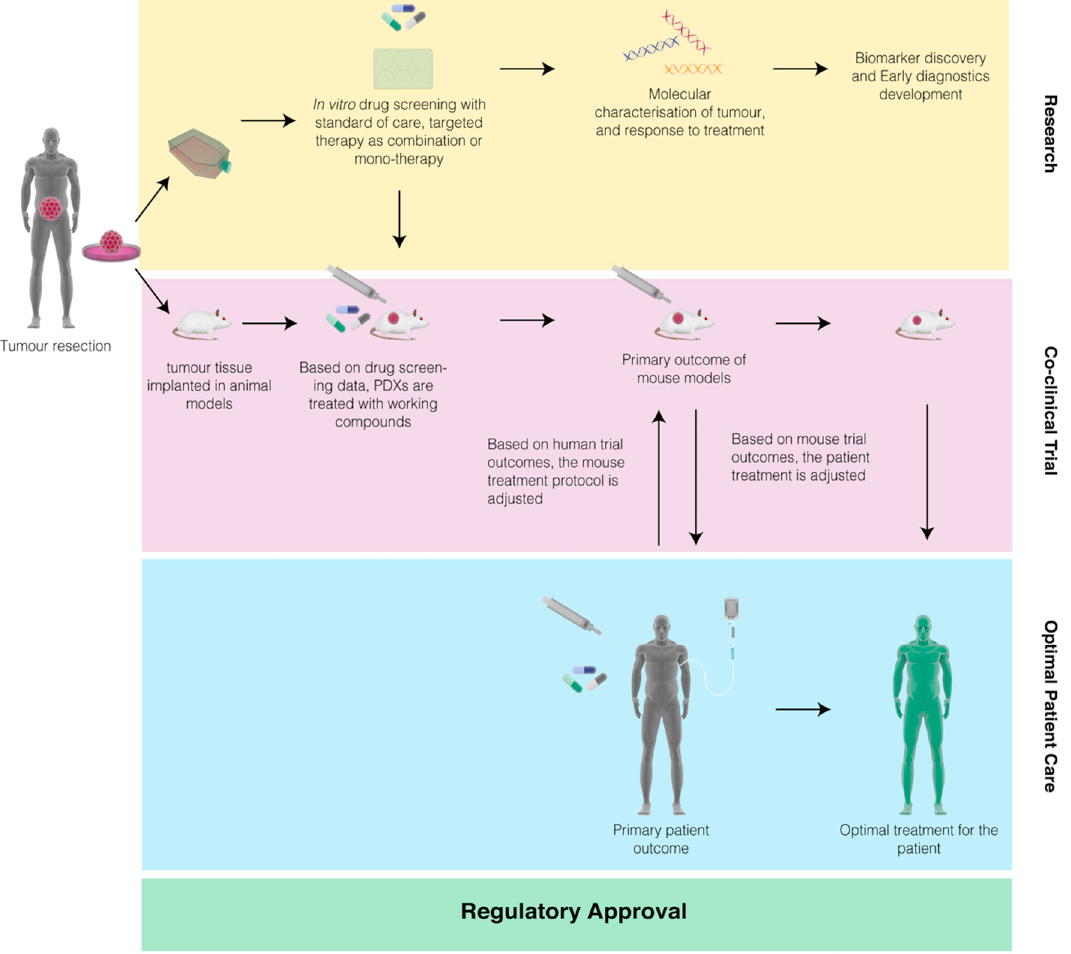
Figure 2. Schematics of co-clinical trials to expedite drug and research development in cholangiocarcinoma (CCA). In this proposed system, the patient is enrolled in the study after being diagnosed with CCA. Post-surgical resection, the CCA tissue is implanted in patient-derived-xenograft (PDX) models and derived into primary cell lines. If the tumor is unresectable, the molecular diagnosis of biopsies will enable researchers to design genetically engineered mouse models (GEMMs) and edited cell line models specific to the patients’ gene signature. The non-animal models are used for molecular profiling and initial drug screening with candidate drugs as monotherapy or in combination with other therapies. The animal models are then treated with prospective treatment protocol based on the initial drug screening. The treatment regime in the patient trials is then adjusted based on the real-time data integration from the animal studies, ensuring that each individual patient always receives optimal care.